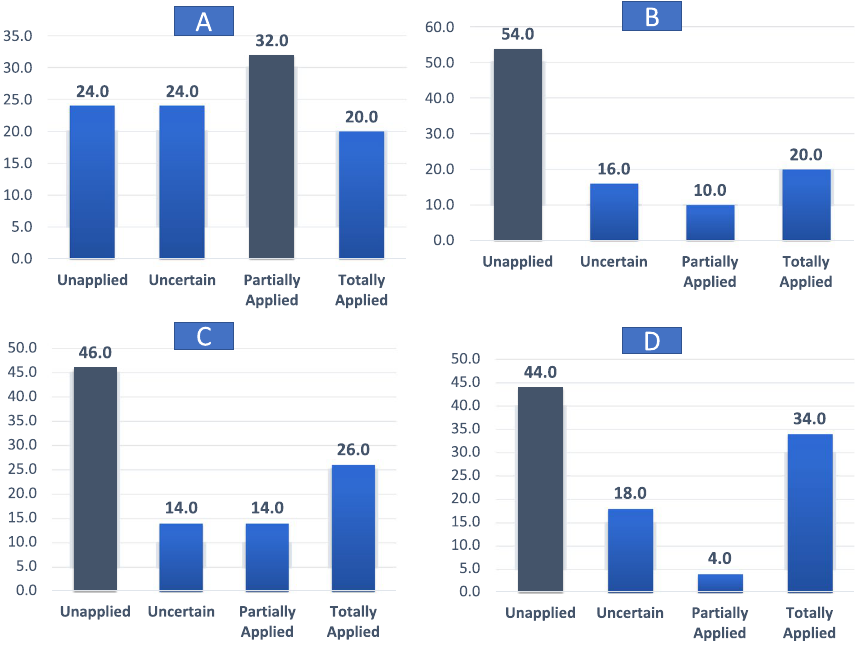
Fig. 11 Relative distribution for resilience